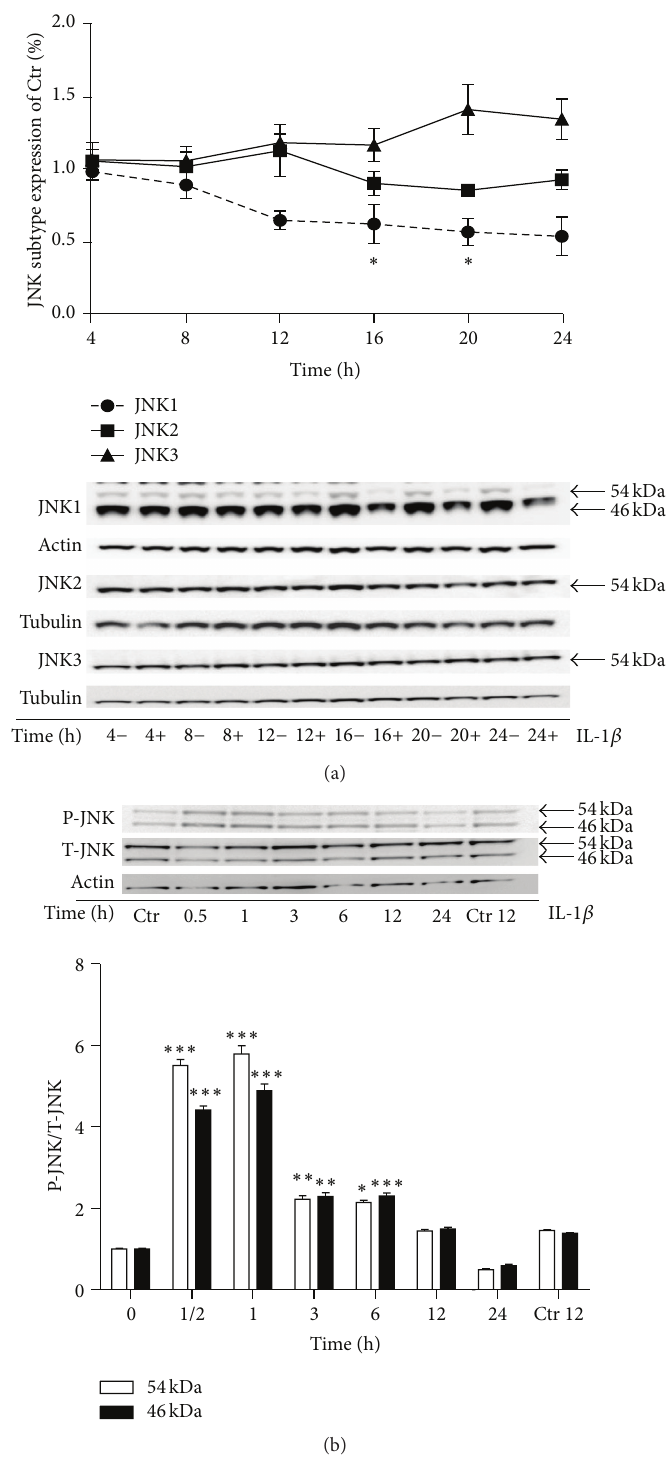
Figure 2: IL-1 𝛽 reduces JNK1 but not JNK2 or JNK3 protein expression and increases P-JNK after 0.5 h of exposure in INS-1 cells. (a) INS-1 cells were exposed to 150pg/mL IL-1 𝛽 or vehicle for 4 to 24 h. JNK subtypes protein expression, JNK1 (circle), JNK2 (square), and JNK3 (triangle), were measured by immunoblotting and normalized to actin or tubulin. Data are shown as % IL-1 𝛽 -regulated JNK subtype expression of their respective nonexposed controls. Data are shown as means of 𝑛 = 3–5 independent experiments ± SEM; ∗ 𝑃 < 0.05 versus 4 h time point. (b) INS-1 cells were exposed to 150 pg/mL IL-1 𝛽 or vehicle for 0.5 to 24h. INS-1 cells exposed for IL-1 𝛽 for 12h were lysed at an earlier time point paralleled with the 12h vehicle ctrl. P-JNK was measured by immunoblotting and normalized to T-JNK. Data are shown as means of 𝑛 = 4 independent experiments ± SEM; ∗ 𝑃 < 0.05 , ∗∗ 𝑃 < 0.01 , and ∗∗∗ 𝑃 < 0.001 versus vehicle (0h). Representative gels are